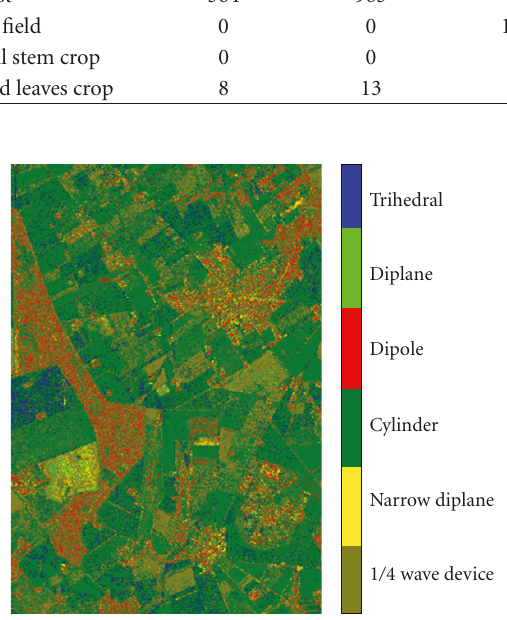
Figure 4: Classification of EMISAR image based on Cameron decomposition.